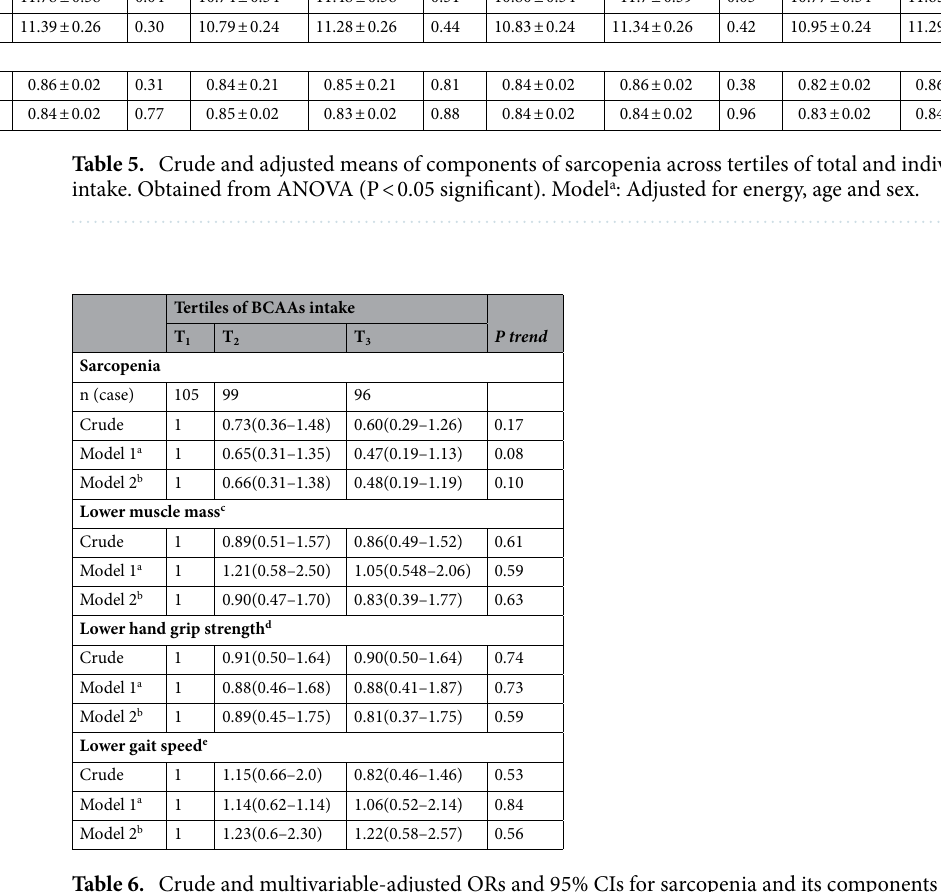
Table 6. Crude and multivariable-adjusted ORs and 95% CIs for sarcopenia and its components across tertiles of BCAAs intake. Data are OR (95% CI). a Model 1: Adjusted for age, sex and energy intake. b Model 2: Further adjusted for physical activity, smoking, alcohol consumption, medication use (statin, corticosteroid, estrogen, testosterone), and positive history of disease. c Muscle mass lower than 5.5 (kg/m 2 ) for women and 7.0 (kg/m 2 ) for men 27 . d Lower muscle strength was defined according previous study 32 . e Gait speeds equal or slower than 0.8 m/s 27 .